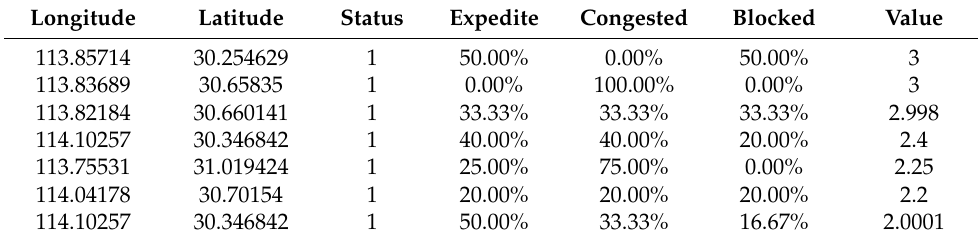
Table 2. Part of the traffic dynamics data display.